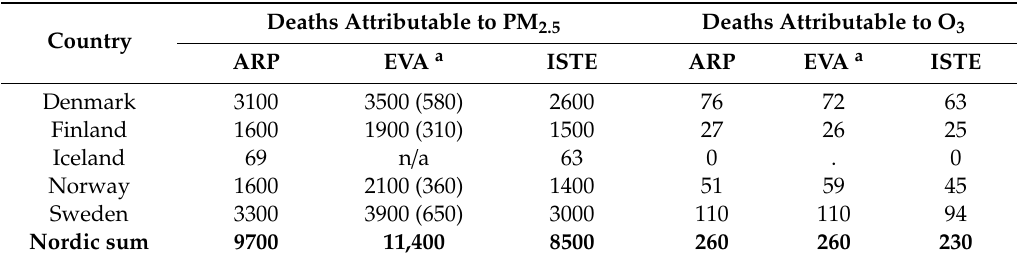
Table 6. Deaths attributable to PM 2.5 and O 3 exposures in Nordic countries in 2015. Deaths Attributable to PM 2.5 Country